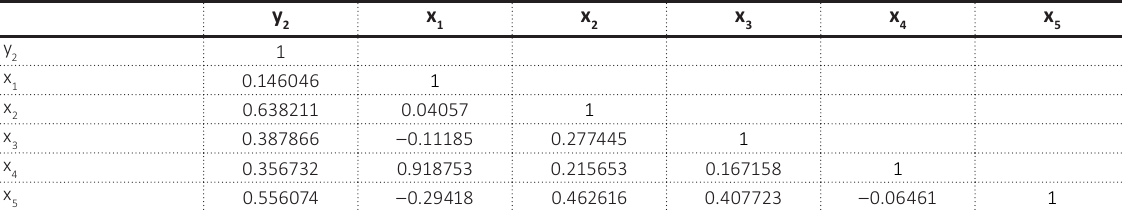
Table 7. Matrix of pair correlation indices of the social progress index (у2) and social spending items у 2